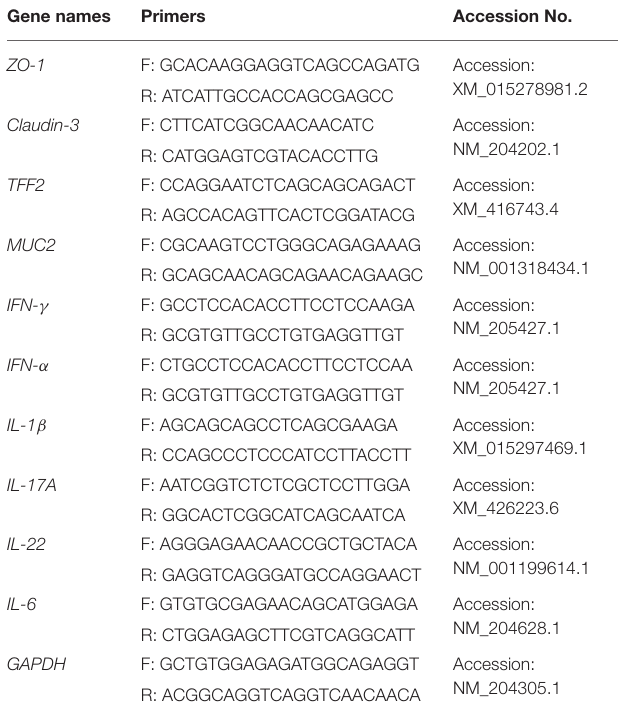
TABLE 3 | Primers for qRT-PCR detection of ileum mucosal barrier related indices and inflammation-related